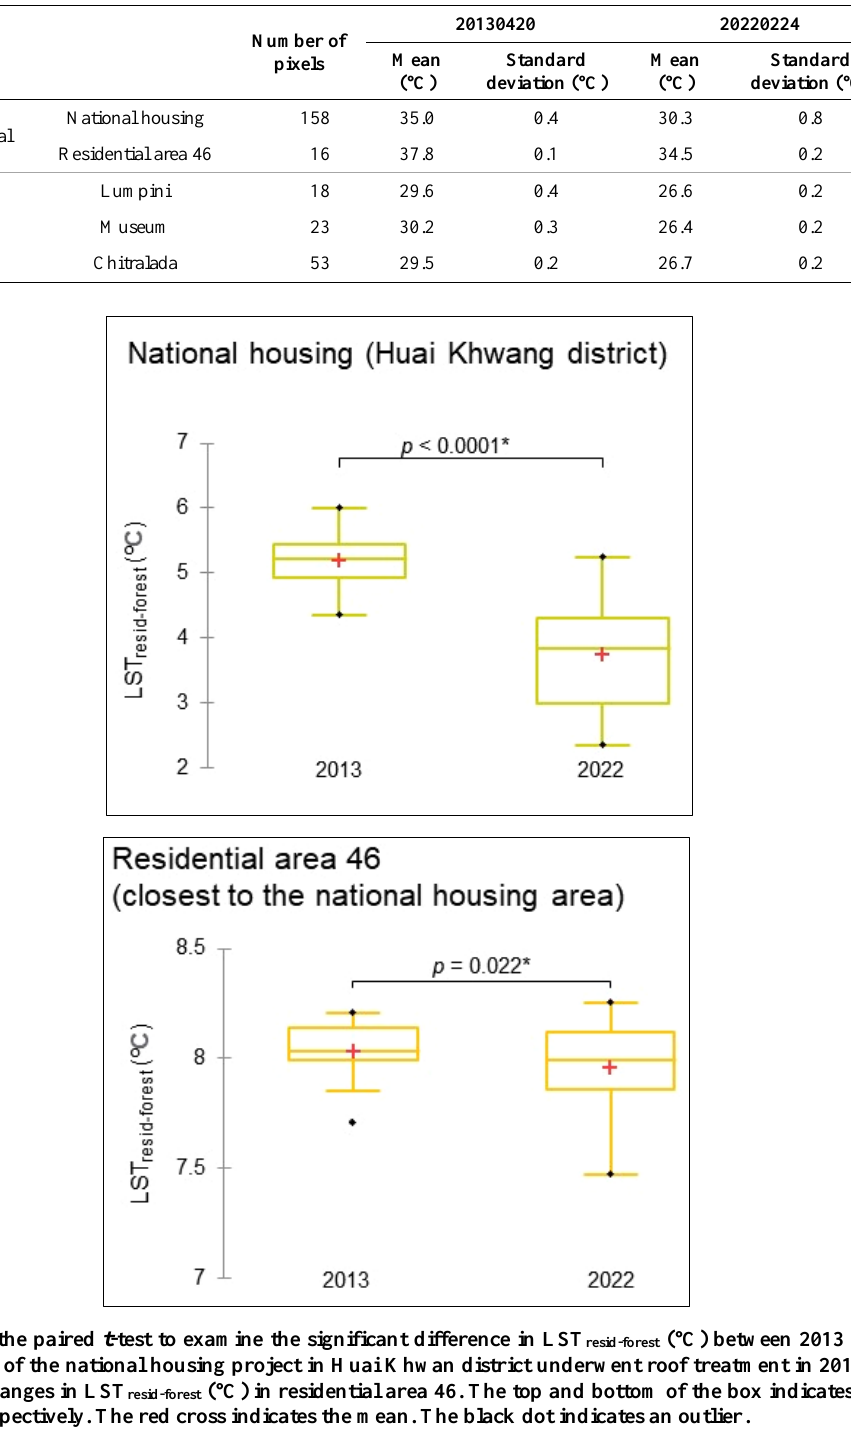
Table 2. Effects of 2014 roof treatment on land surface temperature in the national housing area of Huai Khwang district. As a reference, the closest residential area (area 46) among the 2004 or before housing areas was compared